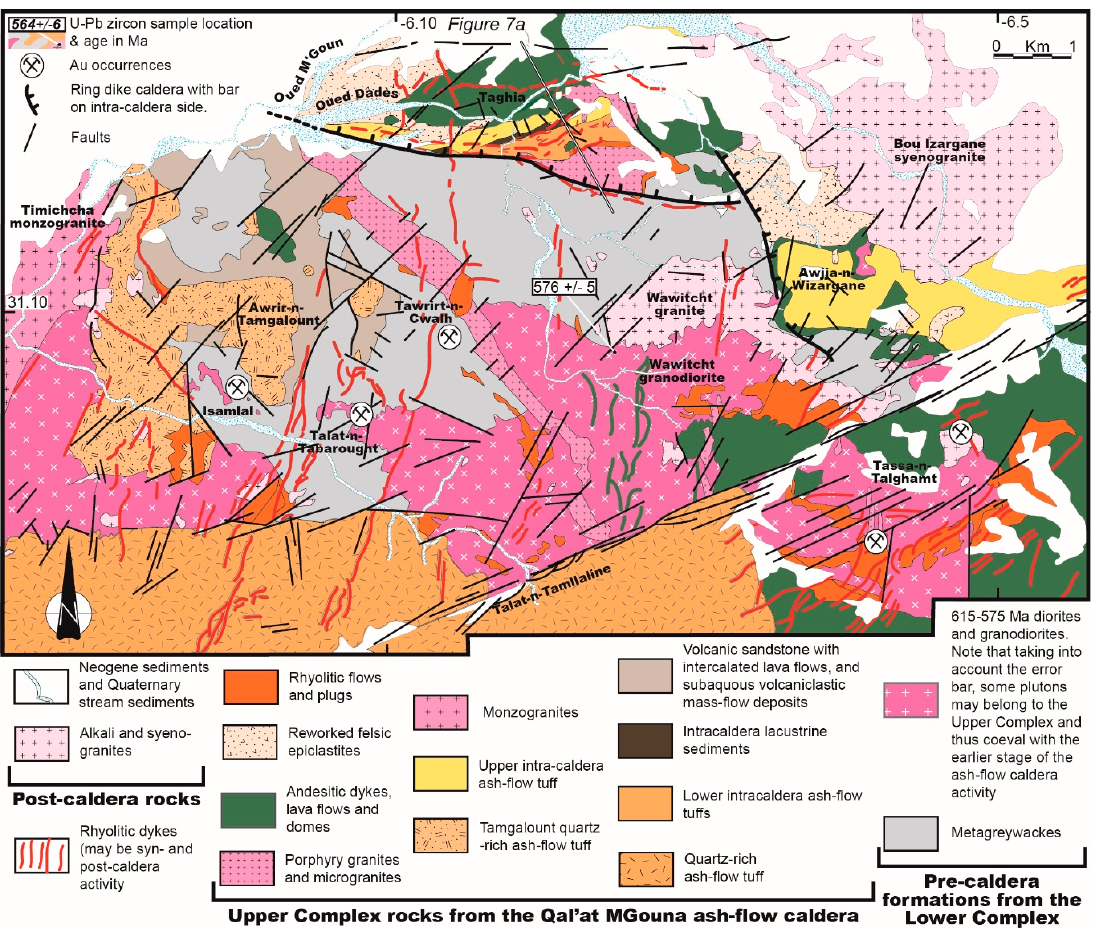
Figure 5. Detailed geologic map of the Qal’at MGouna district showing the extra- and intra-caldera rock units (from Benharref [132], Derré and Lécolle [113] and Tuduri [47]).